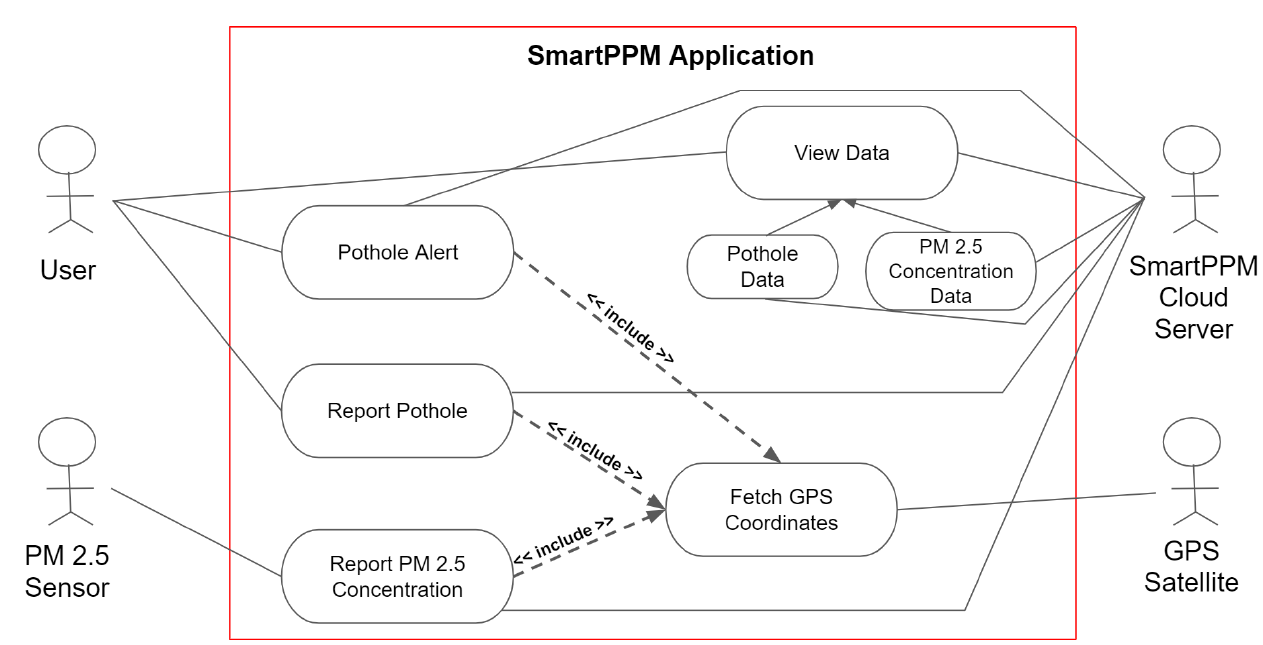
Figure 3. Use case diagram of SmartPPM system.